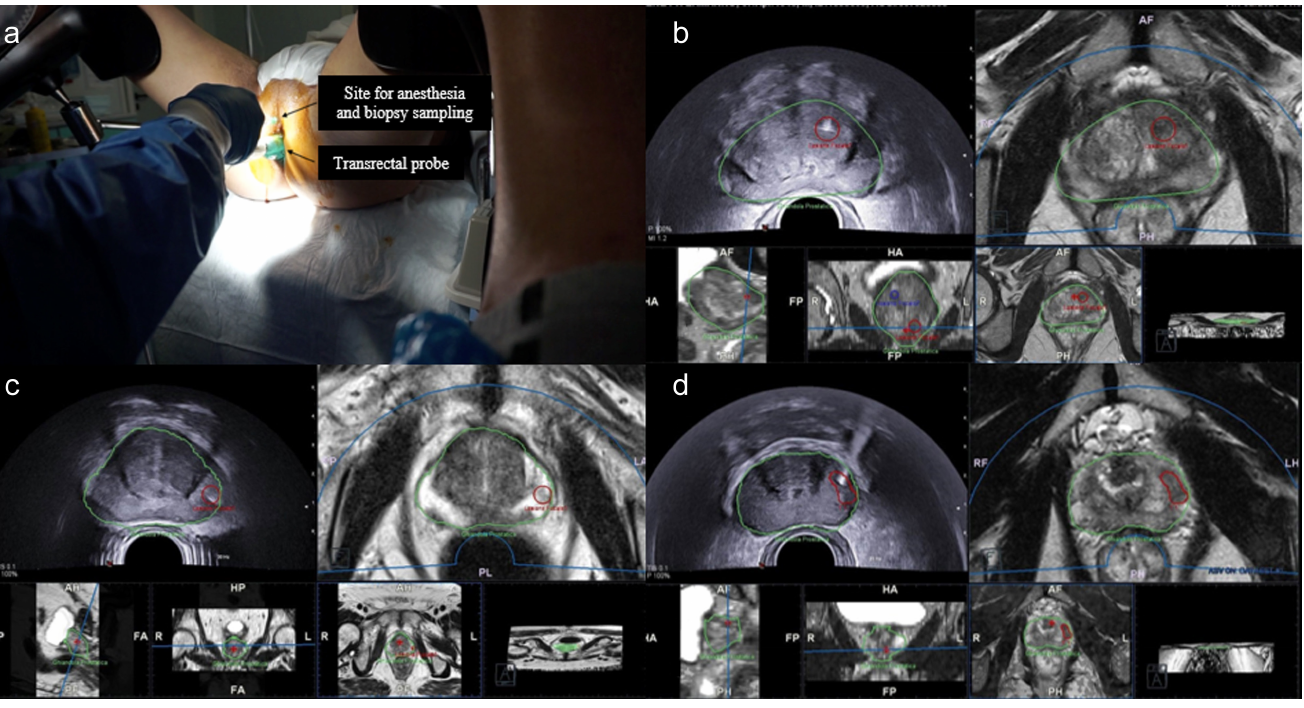
Figure 2. a-d. Target biopsy. The access to the gland was carried out using a single access transperineal approach with local anesthesia (a). A PIRADS 3a score lesion was biopsied respectively in the transition zone (b) and in the peripheral zone (c). A PIRADS 3b score was assigned in the last case (d). Histopathological findings detected an HGPIN, and a GS 6 (3+3) prostate adenocarcinoma in 2/4 target cores and a GS 6 (3+3) prostate adenocarcinoma in 4 out of 4 target cores respectively on b, c, and d examinations. Active Surveillance and curative treatment (radical prostatectomy) were carried out for c and d cases,